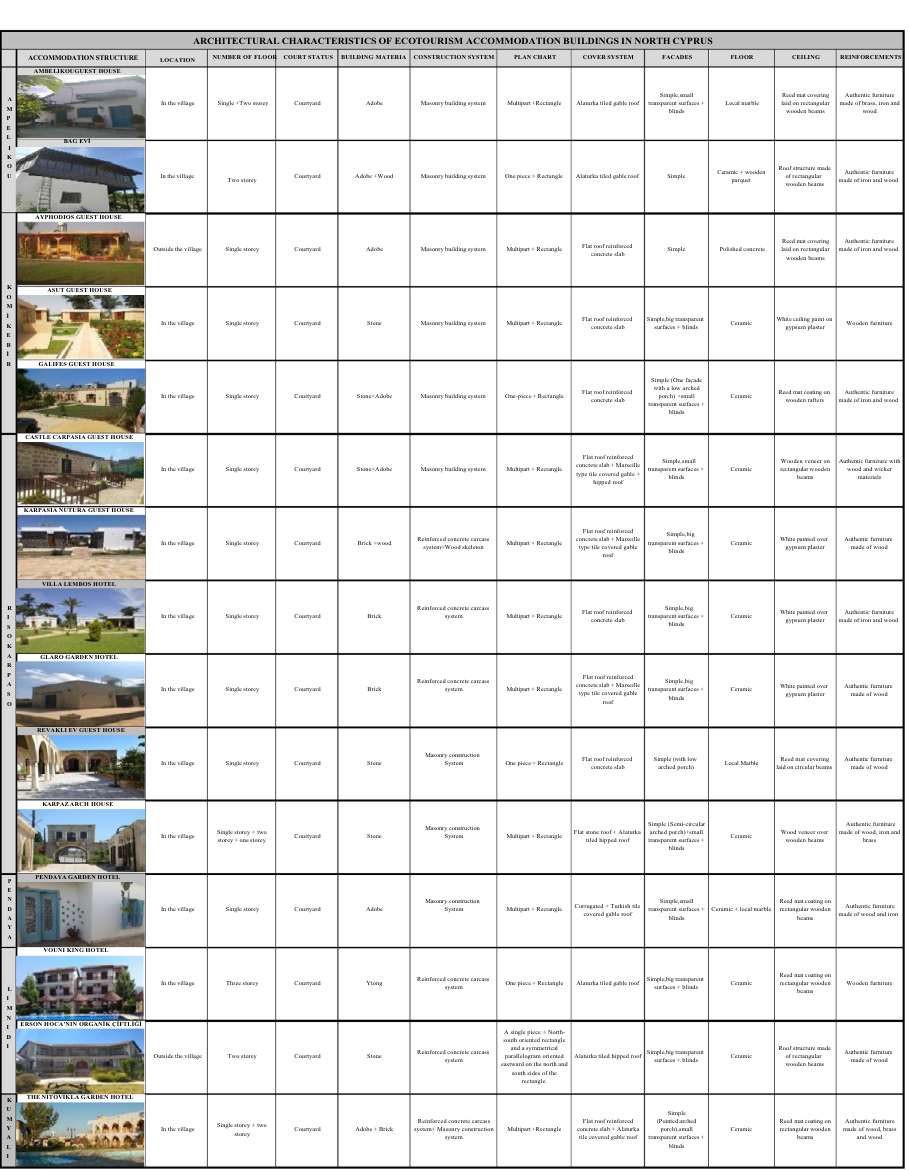
ARCHITECTURAL CHARACTERISTICS OF ECOTOURISM ACCOMMODATION BUILDINGS IN NORTH CYPRUS ACCOMMODATION STRUCTURE LOCATION NUMBER OF FLOOR COURT STATUS BUILDING MATERIA CONSTRUCTION SYSTEM PLAN